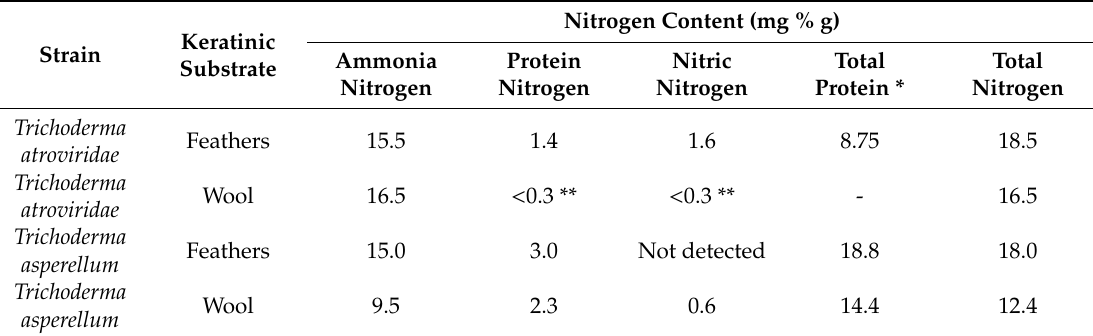
Table 3. Nitrogen content of protein